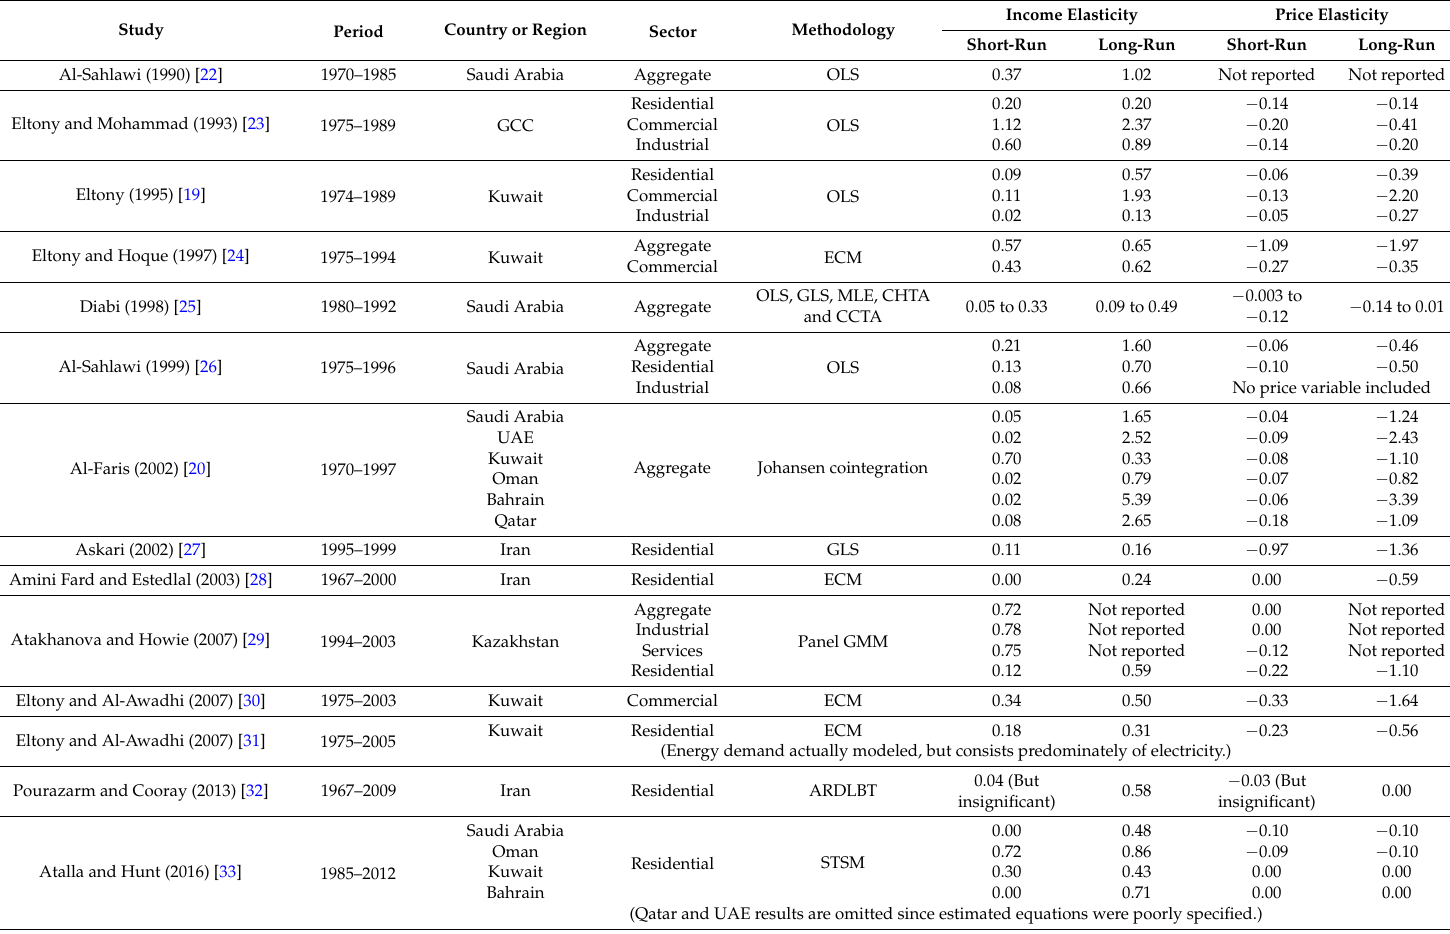
Table 1. Selected studies of electricity demand for resource-rich small open developing